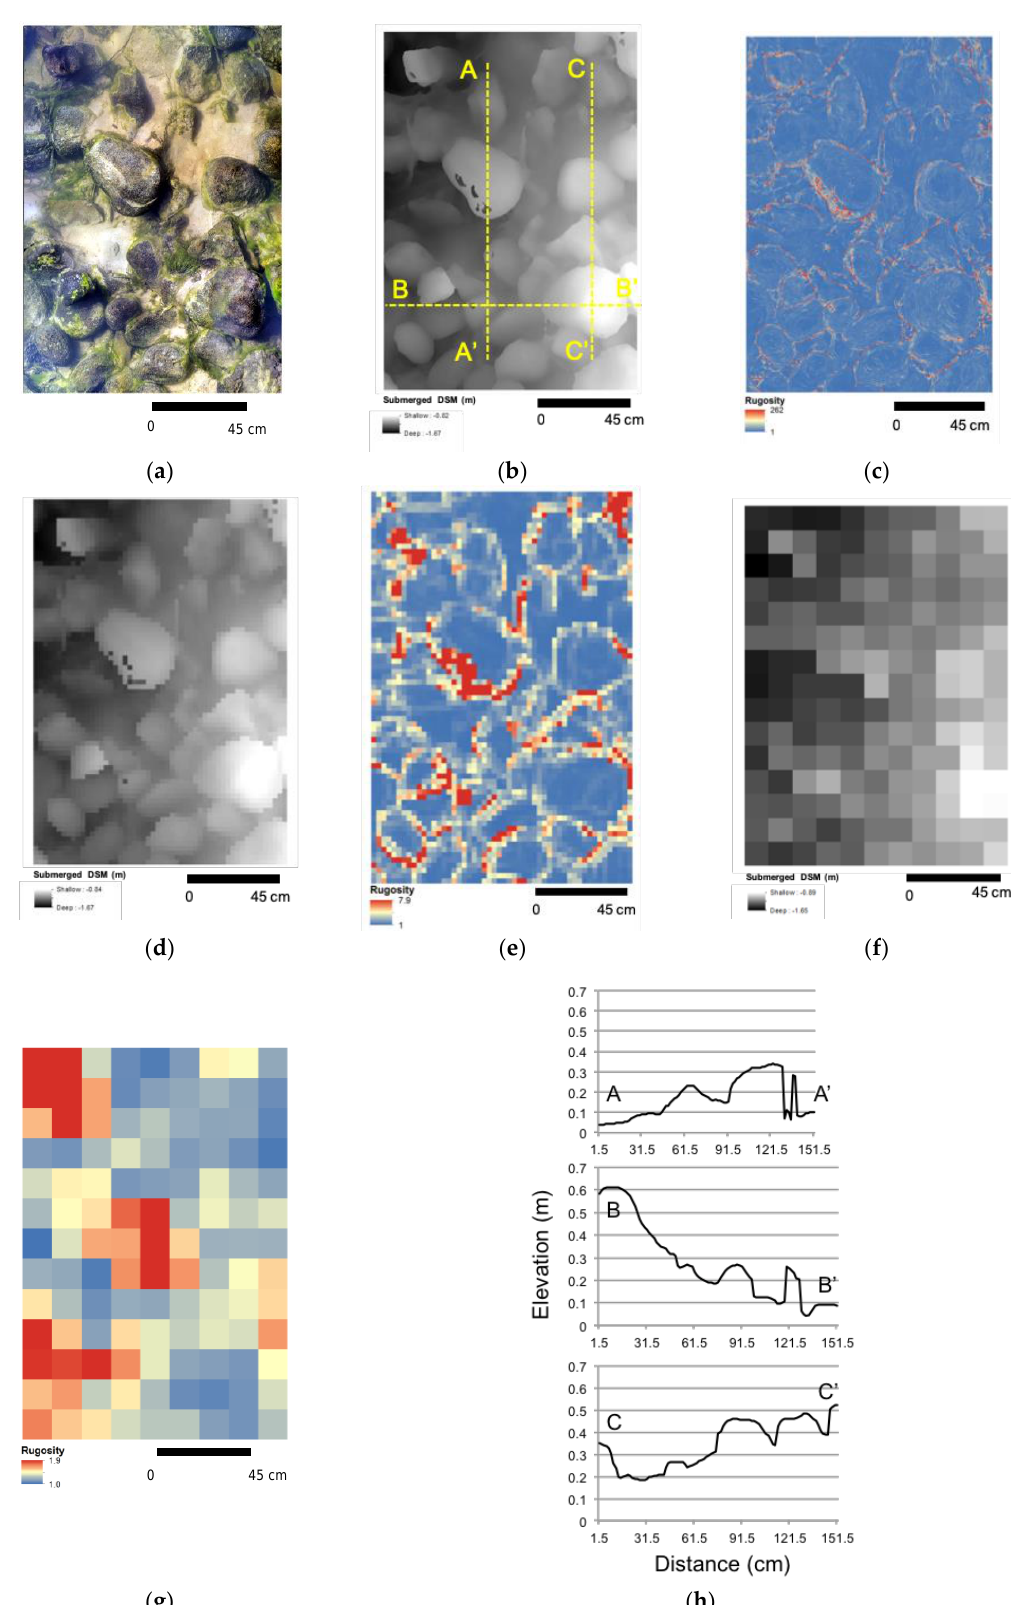
Figure 10. From the underwater SfM-MVS at the Jatobá site, ( a ) Orthomosaic at a GSD of 1 mm. ( b ) Submerged DSM at a GSD of 1 mm. The lines represent the location of the three transects used to